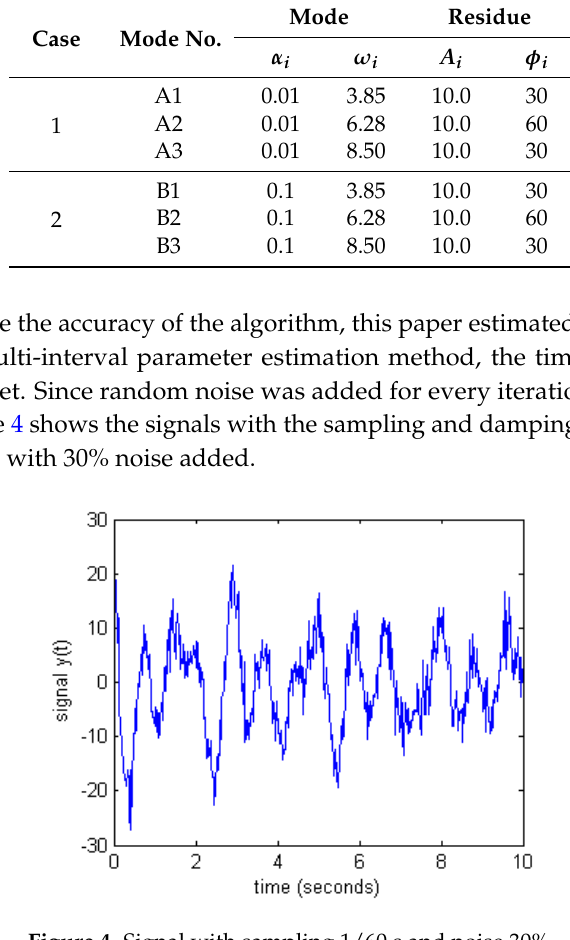
Figure 4. Signal with sampling 1/60 s and noise 30%.